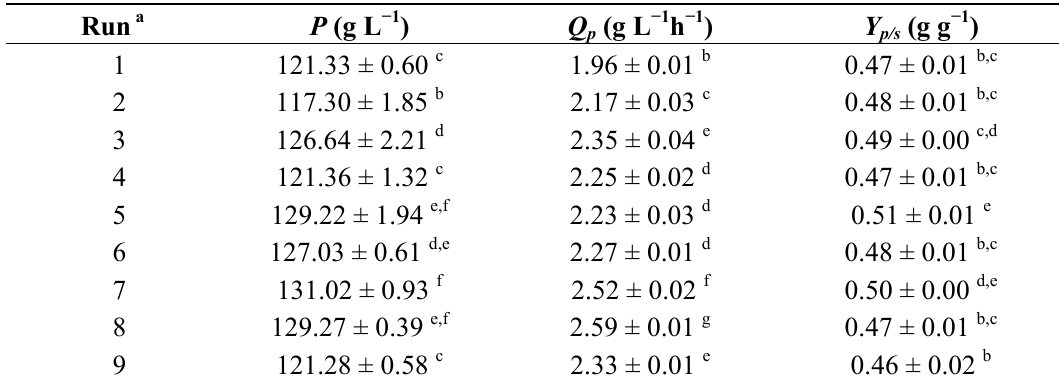
Table 4. Orthogonal experiment results of ethanol concentration ( P ), productivity ( Q and yield ( Y p/s